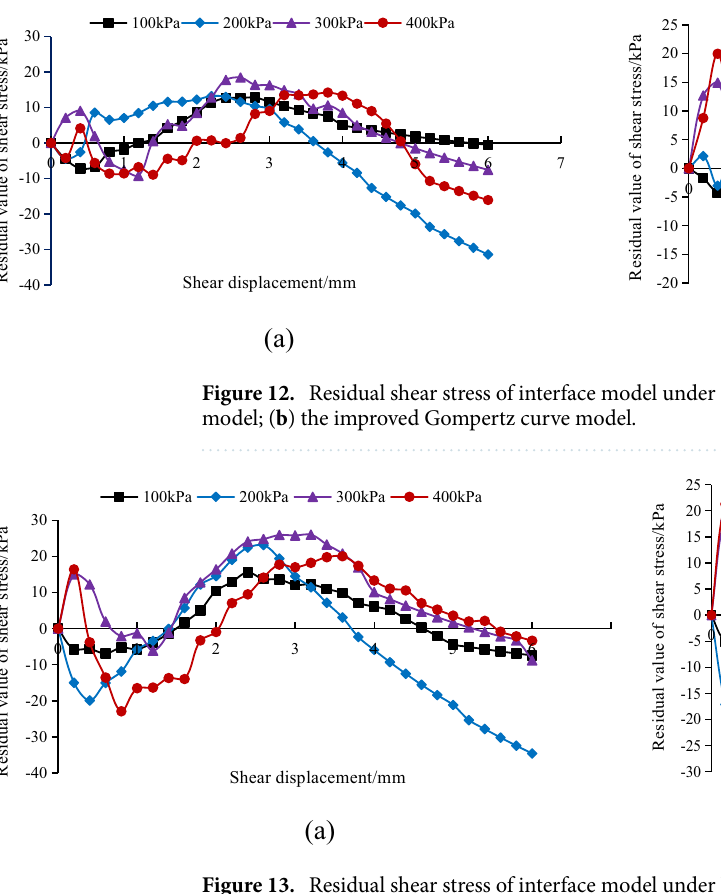
Figure 13. Residual shear stress of interface model under NRS bonding strength. ( a ) The Clough–Duncan curve model; ( b ) the improved Gompertz curve model.